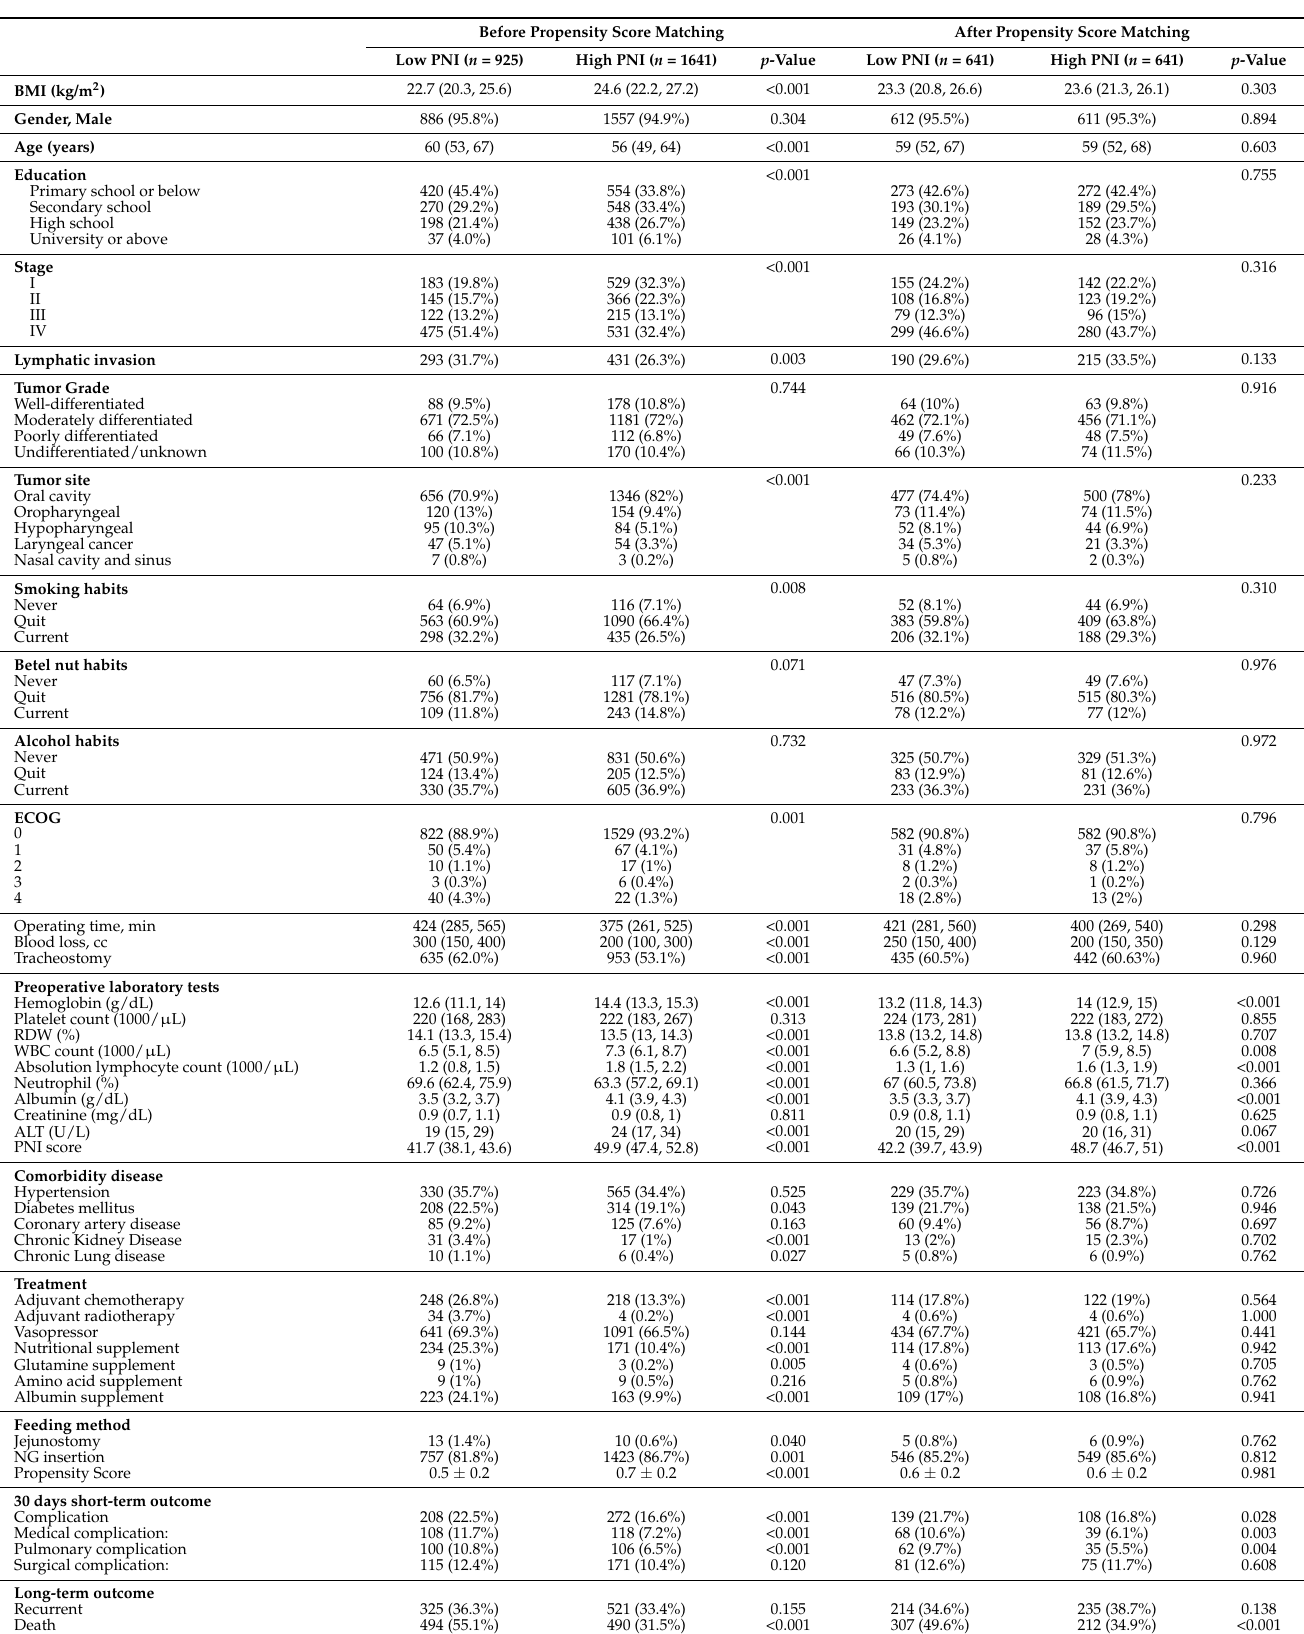
Table 1. The demographics and clinical characteristics divided by cut-off value of PNI score = 45 before and after propensity score